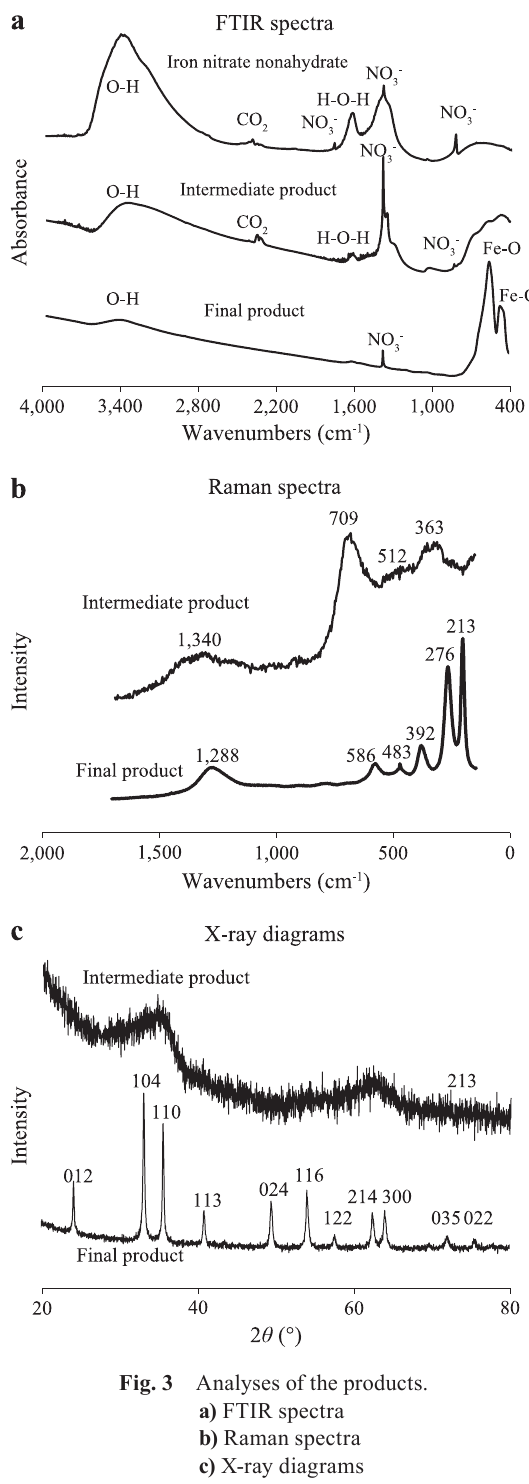
Fig. 2 Mass variation of the solution heated at different tem - peratures in the muffle furnace.